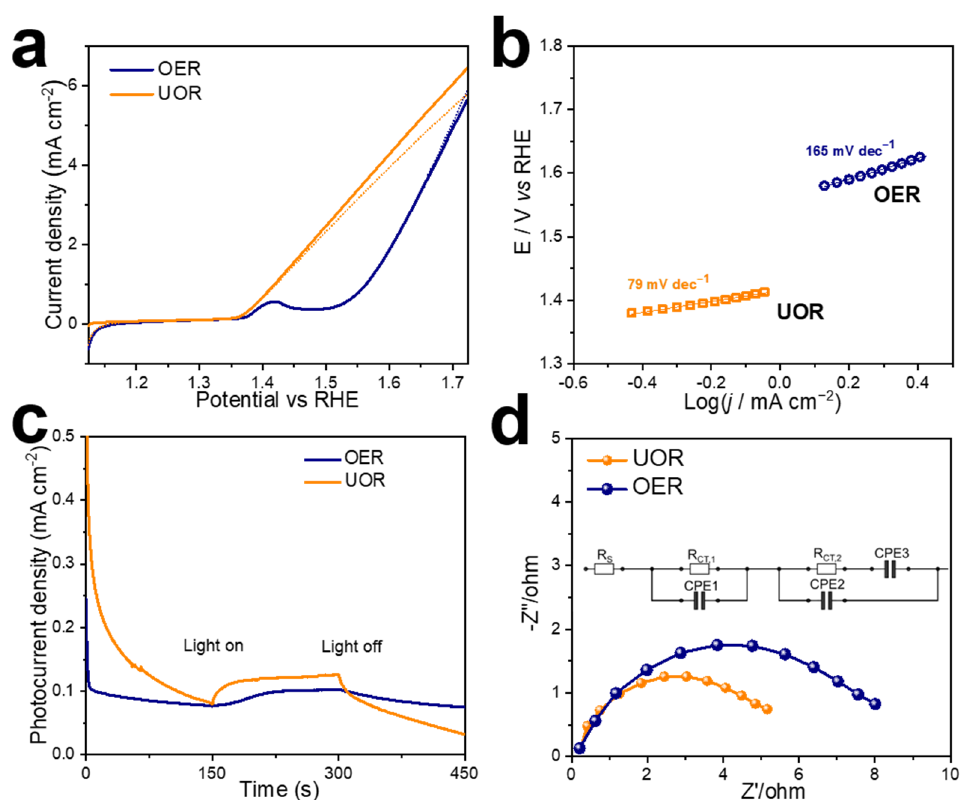
Figure 3. ( a ) Polarization curves for the UOR and OER under NIR light irradiation. The solid line and dotted line were under NIR and dark irradiation, respectively. ( b ) Tafel plots for the UOR and OER derived from ( a ). ( c ) Photocurrent response under NIR light irradiation with urea and without urea. ( d ) Nyquist plots with urea and without urea at open circuit voltage vs. Hg/HgO under NIR light irradiation.